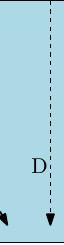
Figure 3: Trajectories (in dashed, black) over geographic context (boundaries shown in bold,